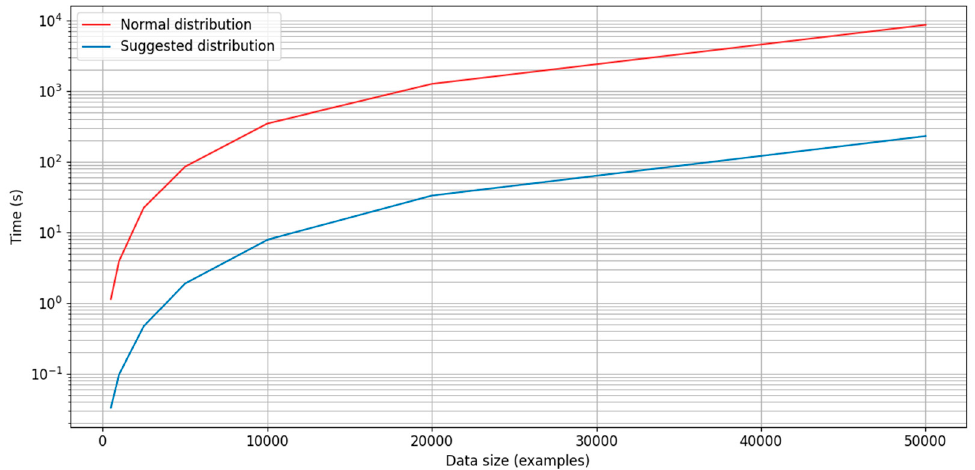
Figure A5. Comparison of processing times for estimating the normal distribution (red) and the suggested distribution (blue) in the present work. Estimations are 34–47 times faster when using the suggested distribution. However, in practice, the estimation only constitutes part of the computations during training; training times depend on the batch size, and for a batch size of 500, training times were approximately 2–2.5 times faster when using the suggested distribution.